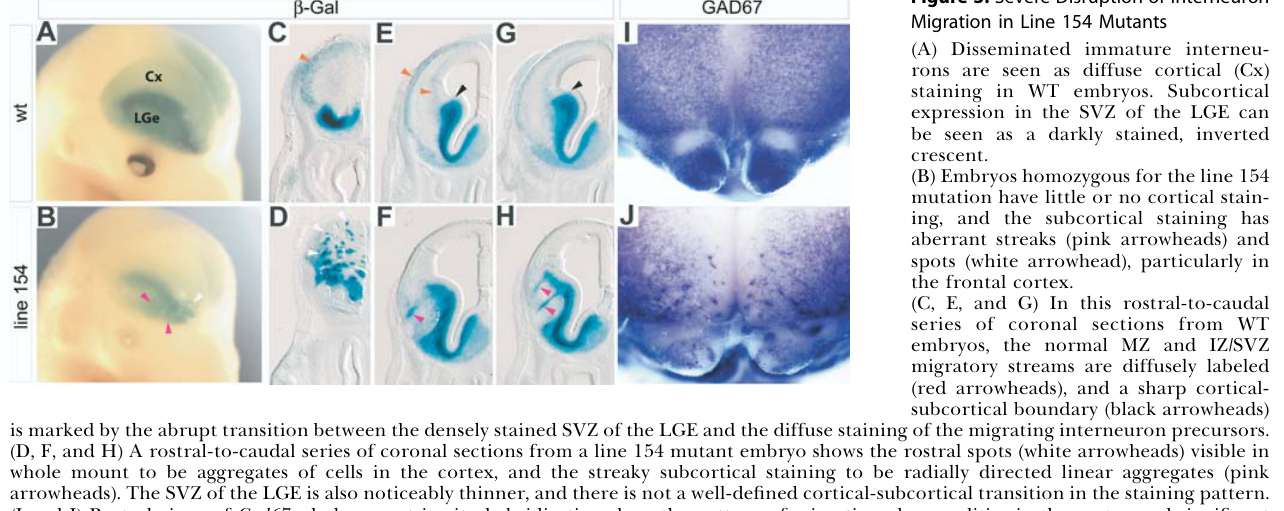
Figure 3. Severe Disruption of Interneuron Migration in Line 154 Mutants (A) Disseminated immature interneu- rons are seen as diffuse cortical (Cx) staining in WT embryos. Subcortical expression in the SVZ of the LGE can be seen as a darkly stained, inverted crescent. (B) Embryos homozygous for the line 154 mutation have little or no cortical stain- ing, and the subcortical staining has aberrant streaks (pink arrowheads) and spots (white arrowhead), particularly in the frontal